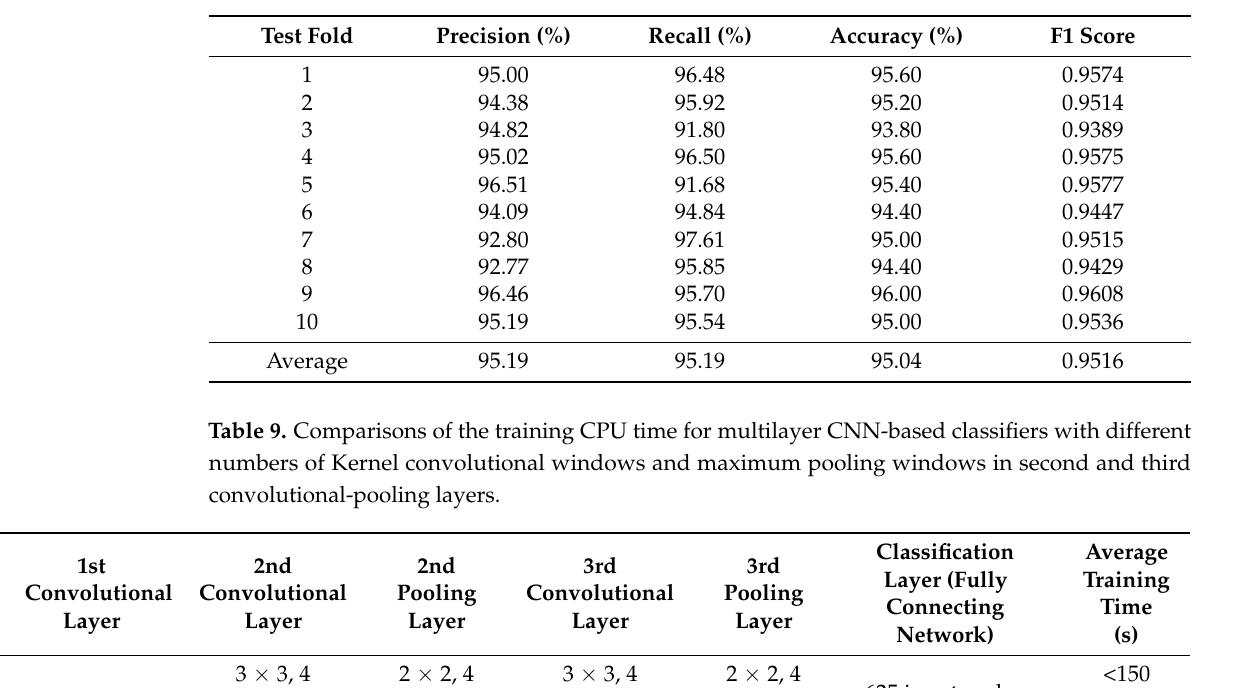
Table 8. Experimental results of K-fold cross-validation ( K f = 10) for the proposed deep-learning- based CNN.